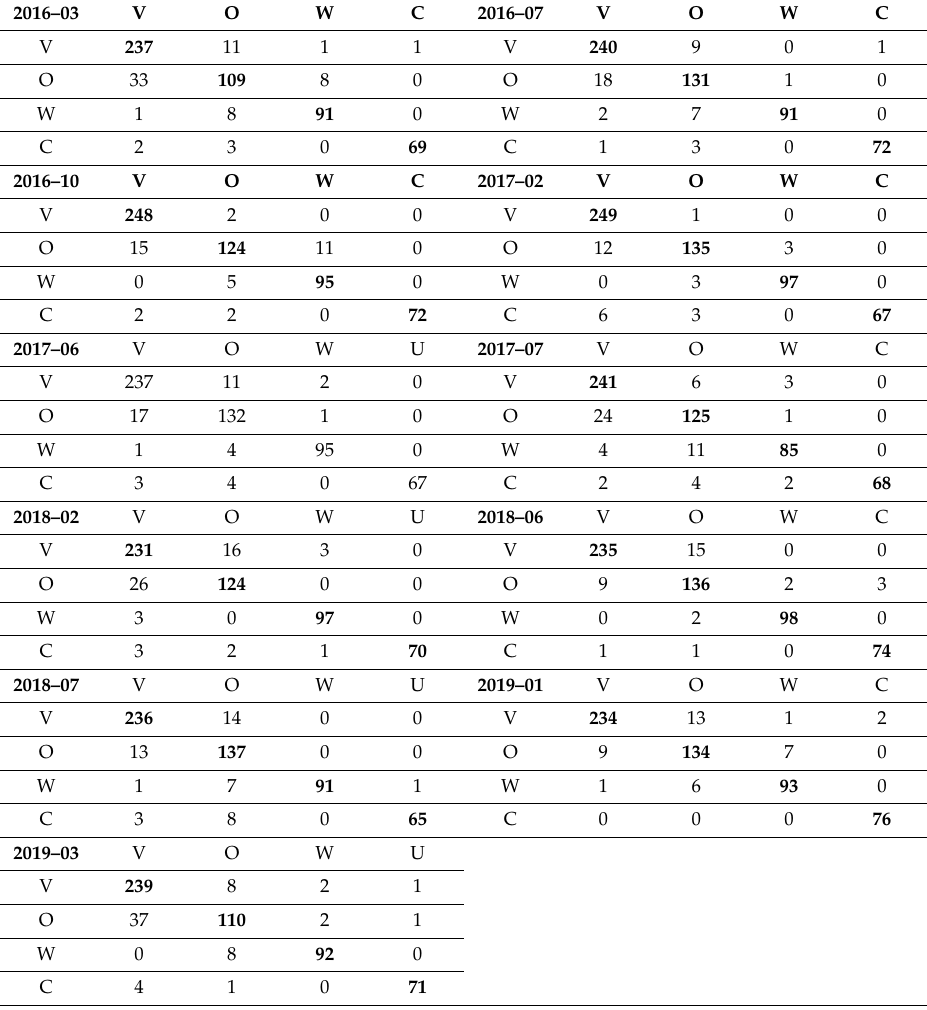
Table A2. Accuracy assessment of the land cover